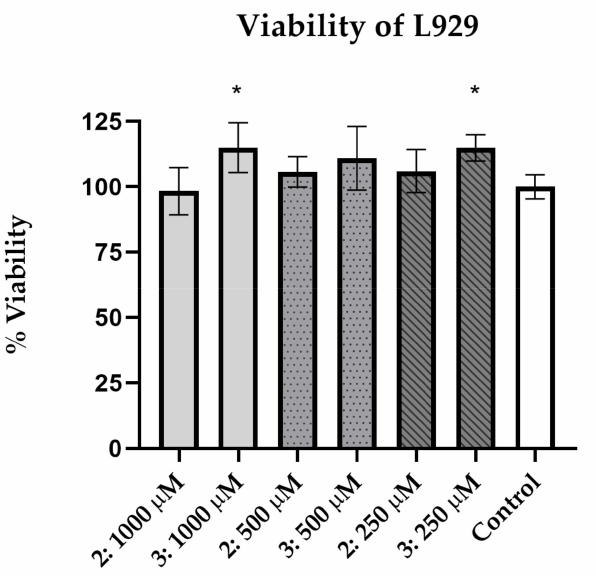
Figure 6. Viability of L929 cells after treatment with 2 and 3 . * Significant difference from control ( p <